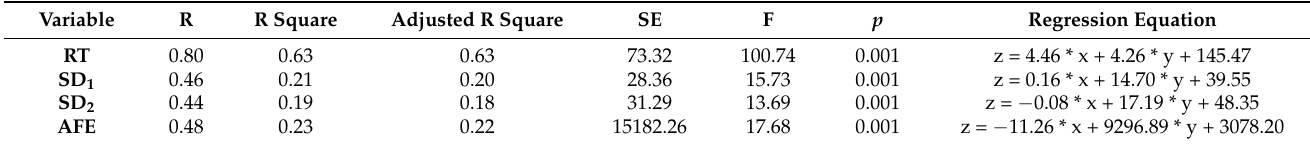
Table 7. Results of the multiple regression analysis for the effect of age and SRH on Poincar é parameters ( n = 120). Variable R R Square Adjusted R Square SE F p Regression Equation